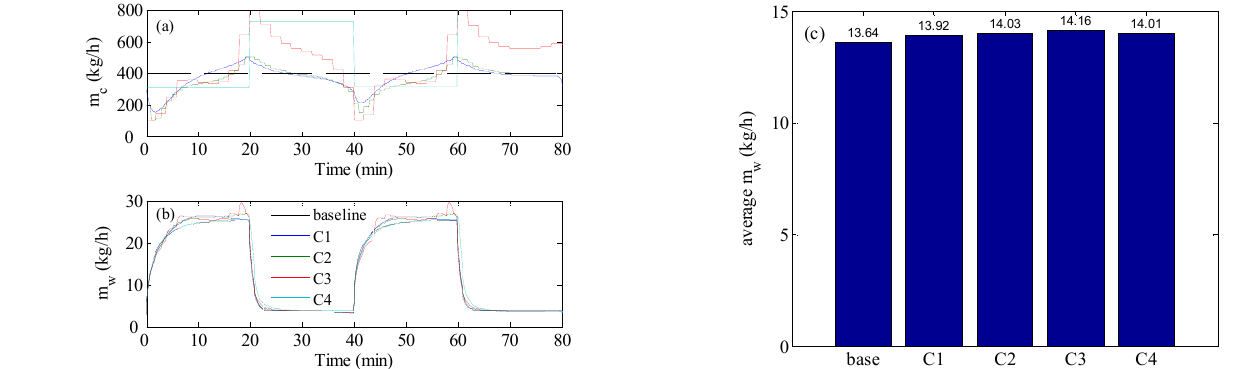
Figure 6. Optimal control result when the inlet temperature varies as a square wave; ( a ) cold stream flow rate, ( b ) mass production rate, ( c ) Time-averaged mass production; C1: T s = 20 s, C2: T s = 1 min, C3: T s = 2 min, C4: T s = 20 min. 𝑚 (cid:3035) is fixed at 400 kg/h.